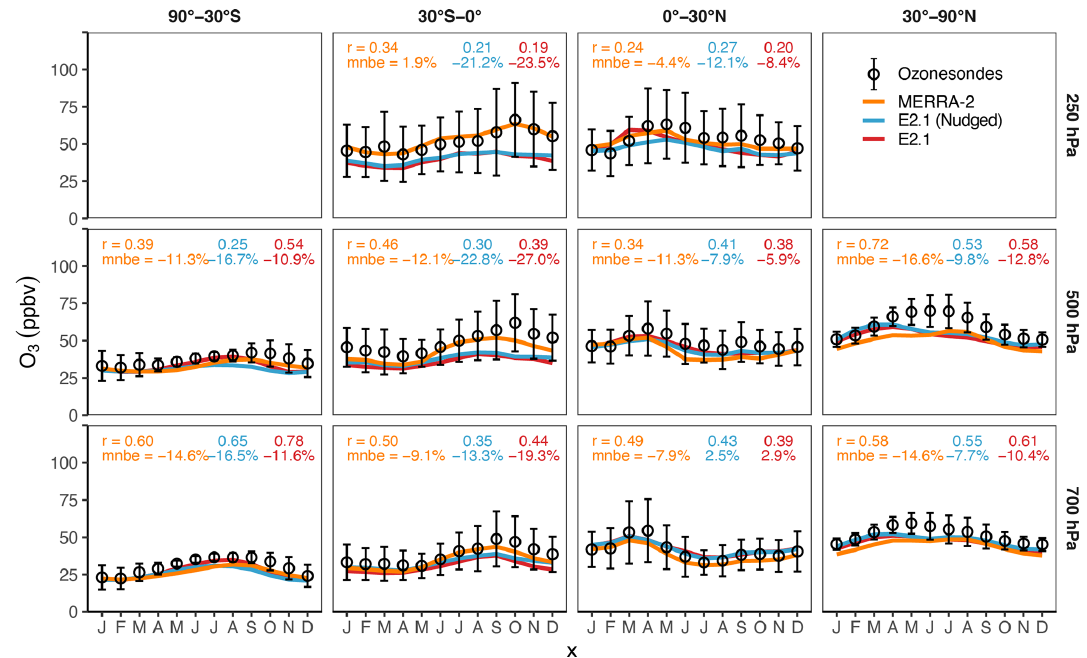
Figure 16. Comparison of the annual cycle of ozone for 2005–2014CE between ozonesonde observations (black circles) and the MERRA-2 (solid orange line), E2.1 nudged to MERRA-2 (blue line), and E2.1 (red line) simulations. Model and observational data were grouped into four latitude bands (90 to 30 ◦ S, 30 ◦ S to 0 ◦ , 0 ◦ S to 30 ◦ N, and 30 ◦ S to 90 ◦ N) and sampled at three altitudes (700, 500, and 250hPa), with the models sampled at locations and months of the ozonesonde measurements before averaging together. Error bars on the observations indicate the average interannual standard deviation for each group of observations. The correlation ( r ) and mean normalized bias error (mnbe) for the MERRA-2 (orange), E2.1 nudged to MERRA-2 (blue), and E2.1 (red) means versus the observations are also indicated in each